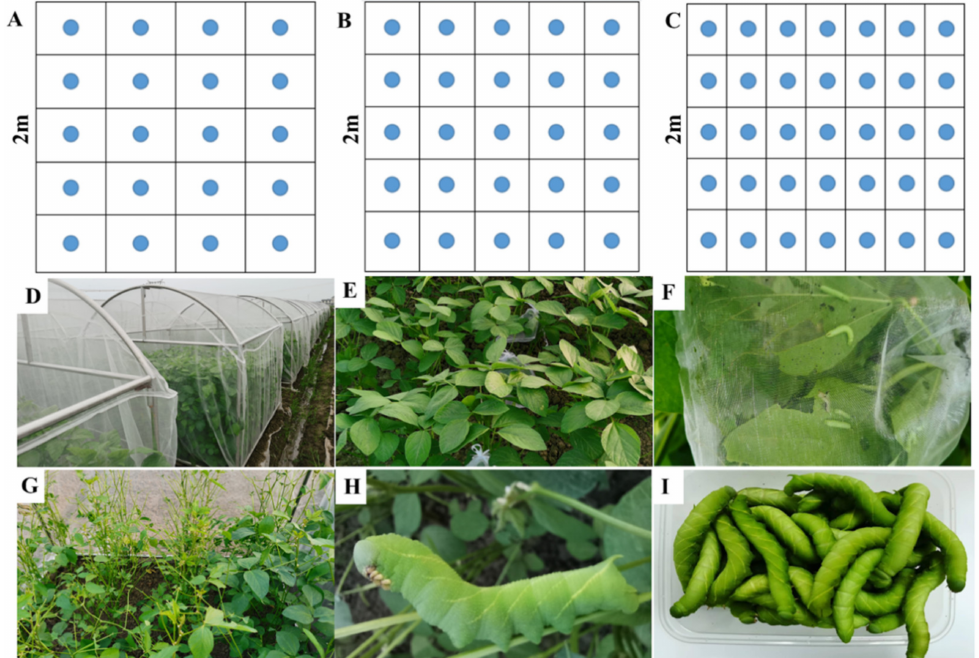
Figure 1. The cultivation mode of the soybean and C. bilineata tsingtauica rearing process in net houses. ( A – C ): soybean sowed in a 2 m × 2 m net house in spring sowing, blue circles represent soybean plants (hills); ( A ) 0.4 m × 0.5 m row spacing; ( B ) 0.4 m × 0.4 m row spacing; ( C ) 0.4 m × 0.3 m row spacing; ( D ) soybean was grown in net houses; ( E ) soybean leaves were bagged to inoculate eggs; ( F ) larvae fed on leaves in the mesh bag (15 cm × 20 cm); ( G ) soybean plants were fed on freely by larvae; ( H ) larvae habitually clung to the soybean petiole; ( I ) larvae harvested. 2.4. Evaluation of C. bilineata tsingtauica Rearing Factors under Autumn Sowing